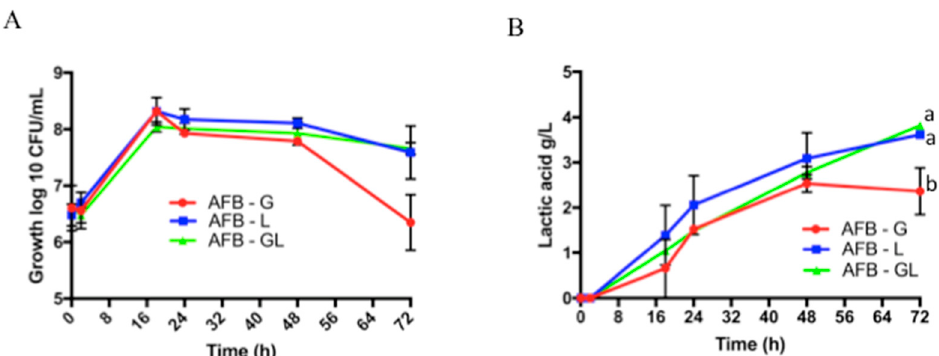
Figure 1. Microbial growth and lactic acid concentrations on three AFBs. ( A ) Bacterial growth in log 10 CFU/mL and ( B ) lactic acid production in g/L, during fermentation on three different AFBs: AFB-G, with glucose as carbon source; AFB-L, with LBA as carbon source; AFB-GL, with a mix (1:1 ratio) of glucose and LBA. Bars represent standard deviation of three independent experiments. Different letters indicate significant differences ( p < 0.05).